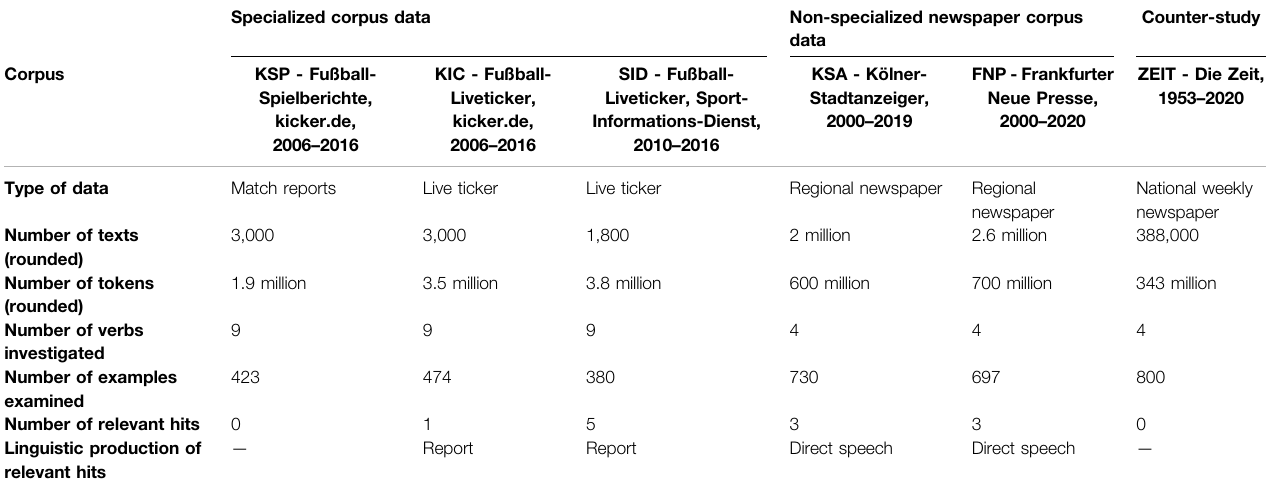
TABLE 1 | Overview of the German corpus